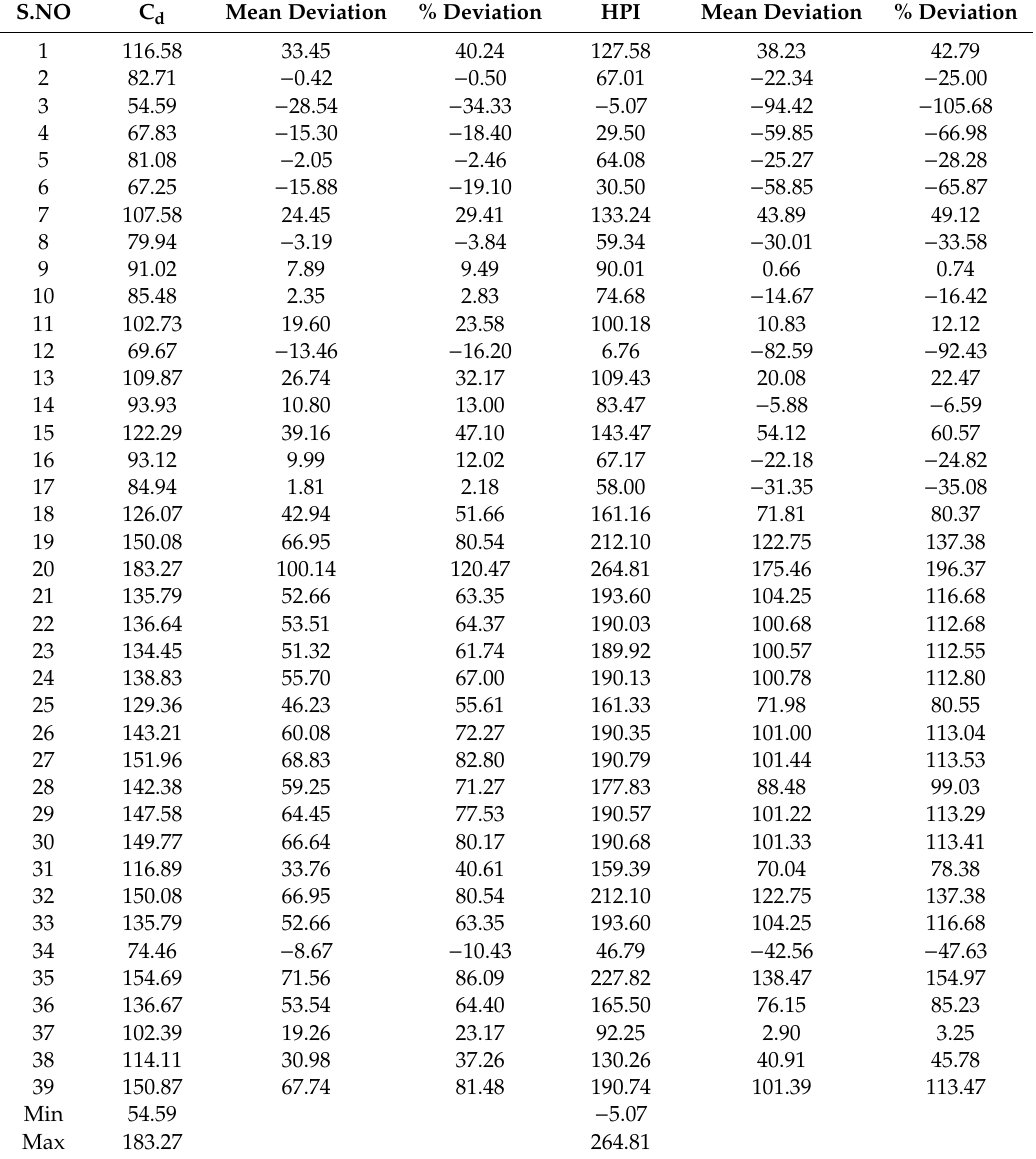
Table 5. Pollution indices for the groundwater